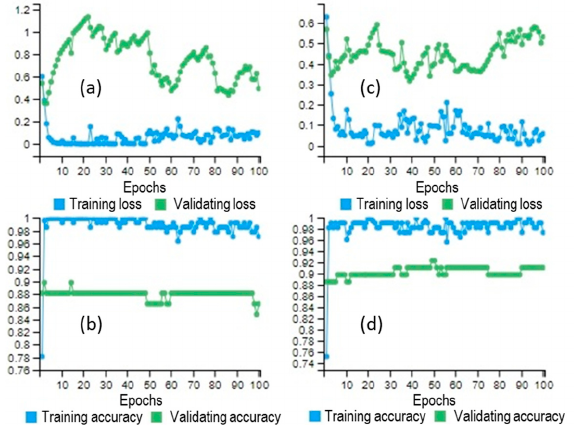
Figure 7. DLNN based ensemble running outputs ( a ). Training and Validating loss of DLNN-FR; ( b ). Training and Validating accuracy of DLNN-FR; ( c ). Training and Validating loss of DLNN- WOE; ( d ). Training and Validating accuracy of